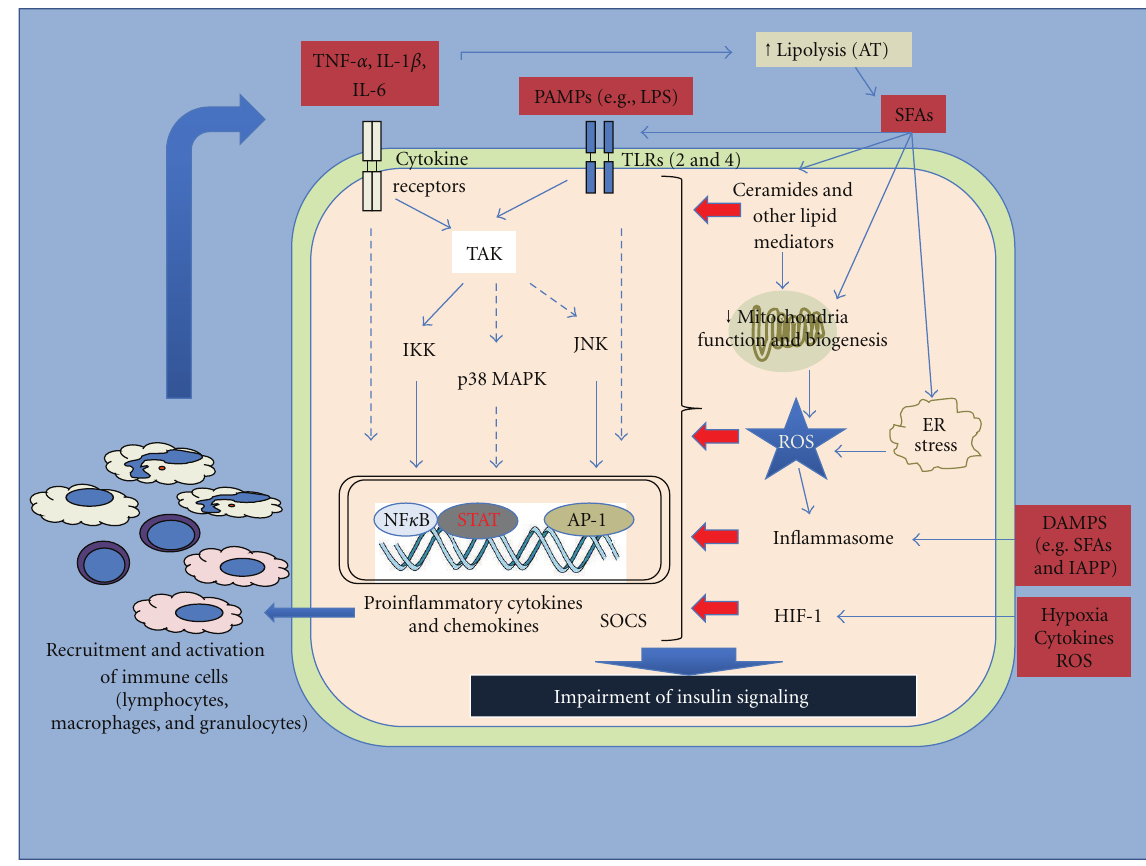
Figure 2: Inflammatory pathways activated during obesity and their cross talk with insulin signaling. Di ff erent signals act directly through membrane (e.g., toll-like receptors [TLRs] and cytokine receptors) and intracellular proteins (inflammasomes) or indirectly by their e ff ect on cell organelles such as mitochondria and endosomal reticulum and generation of metabolites (e.g., ceramides and other lipid mediators) to activate inflammatory pathways. Transcription factor such as nuclear factor κ B (NF κ B), activator protein-1 (AP-1), and signal transducers and activators of transcription (STAT) are activated downstream to these pathways and lead to the expression of proteins that inhibit insulin signaling and induce a pro-inflammatory state by recruiting and activating immune cells. AT, adipose tissue; DAMPS, damage associated molecular patterns; ER, endoplasmic reticulum; HIF-1, hypoxia factor-1; IAPP, islet amyloid polypeptide; PAMPS, pathogen associated molecular patterns; ROS, reactive oxygen species; SFAs, saturated fatty acids; SOCS, suppressor of cytokine signaling; TAK, transforming growth factor β -activated